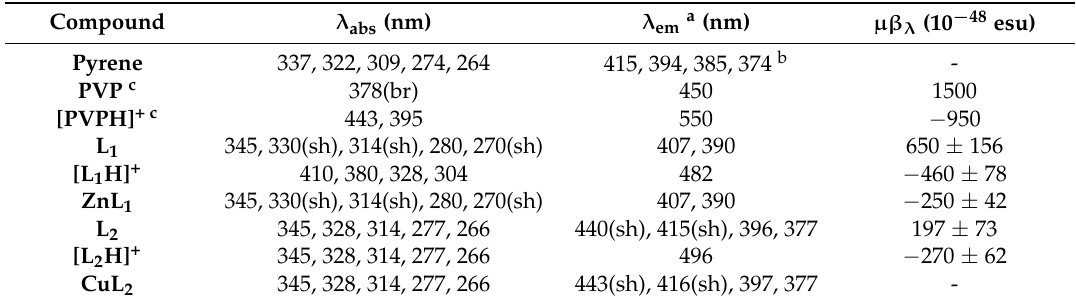
Table 1. Linear and nonlinear optical properties of L 1 , L 2 , and their derivatives together with pyrene and PVP reference